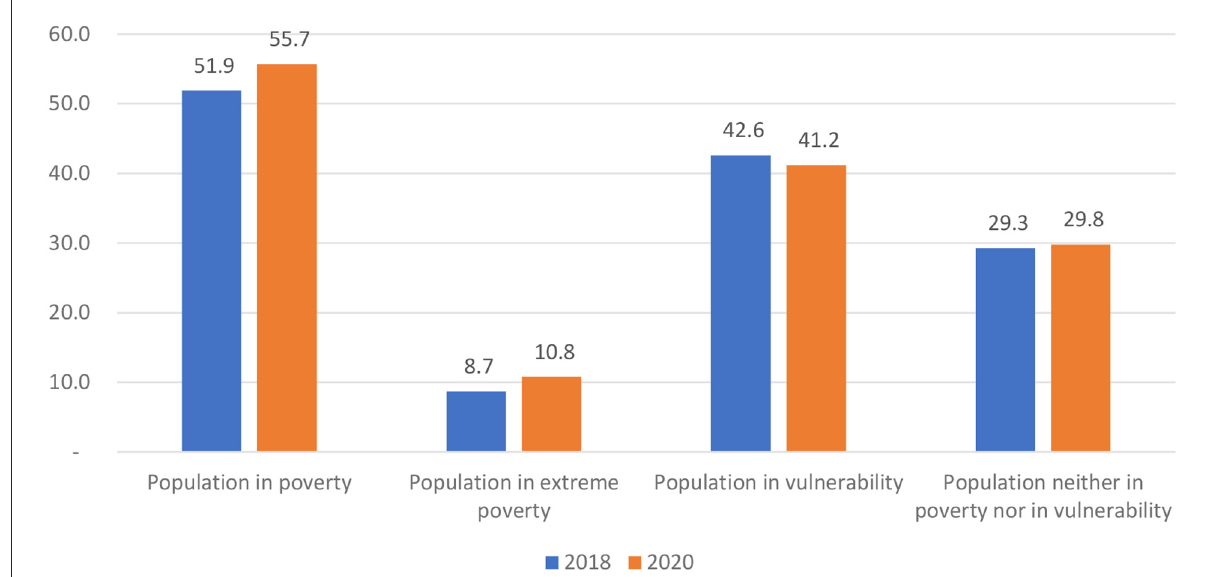
FIGURE3 Changes in poverty categories in Mexico, 2018–2020 (million). Source: Based on data published by the Mexican National Commission for the Evaluation of Social Development